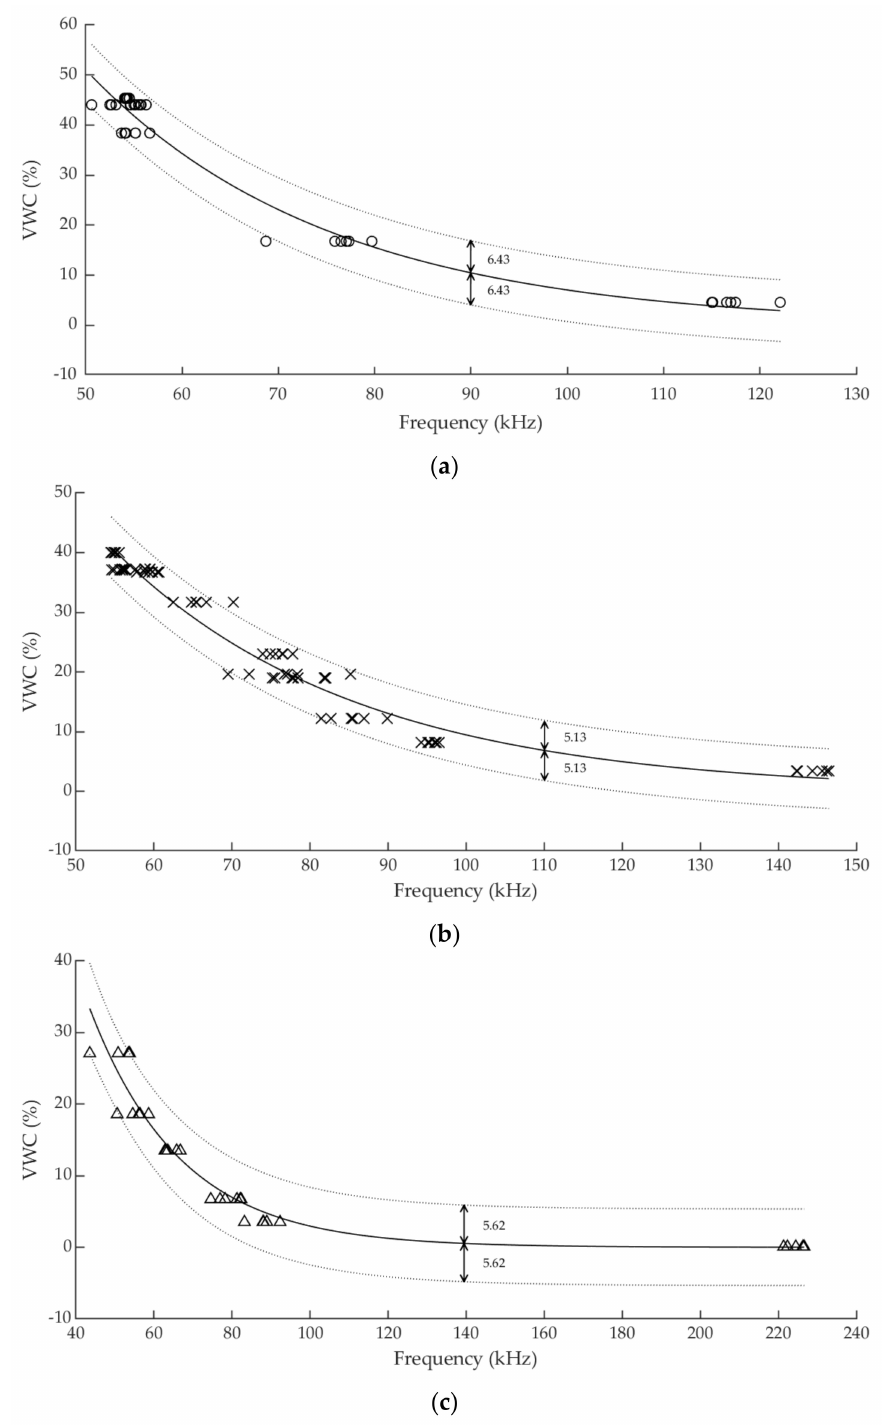
Figure 6. Prediction bounds for calibration fitting in: ( a ) soil (i), ( b ) soil(ii) and ( c ) soil